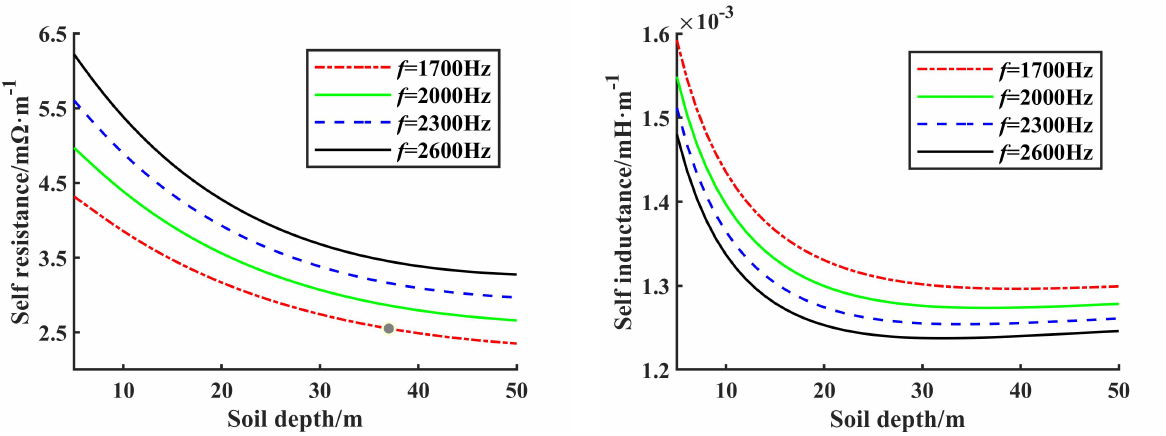
Fig. 12. Variation of rail self-impedance with soil